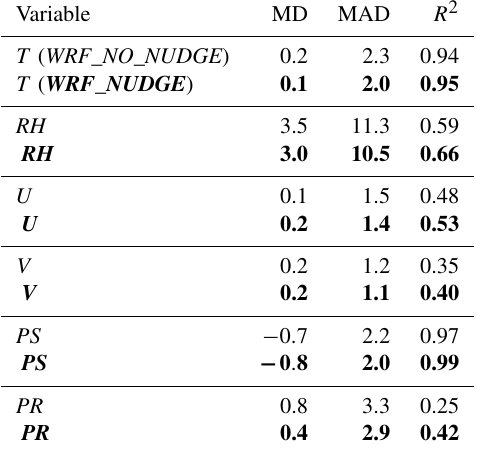
Table 3. A summary of the statistical evaluation of the WRF_NO_NUDGE (italics) and WRF_NUDGE (bold italics) sim- ulations, considering the evaluation period of 1 September 2017 to 1 September 2018. The table presents the mean deviation (MD), the mean absolute deviation (MAD) and the coefficient of determina- tion ( R 2 ) for 2-hourly 2m air temperature ( T ) and relative humidity RH), 10m zonal wind ( U ) and meridional wind ( V ), surface pres- sure (PS), and daily total precipitation (PR). All computations are made from observations minus model data.